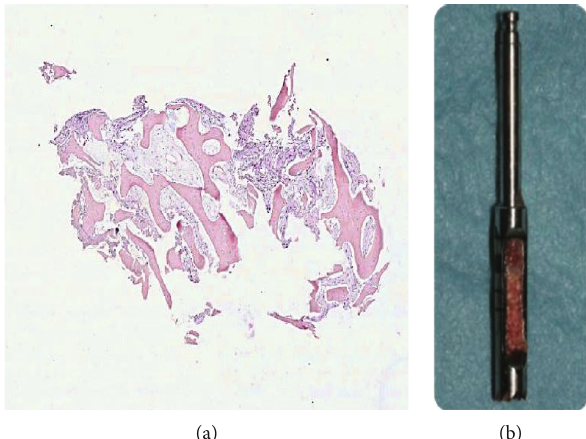
Figure 3: Histological specimen of the bone tissue taken at the center of the grafted site showing bone tissue surrounded by connective tissue matrix. Hematoxylin-eosin staining; (a) original magni fi cation × 5; (b) surgical trephine bur with bone tissue